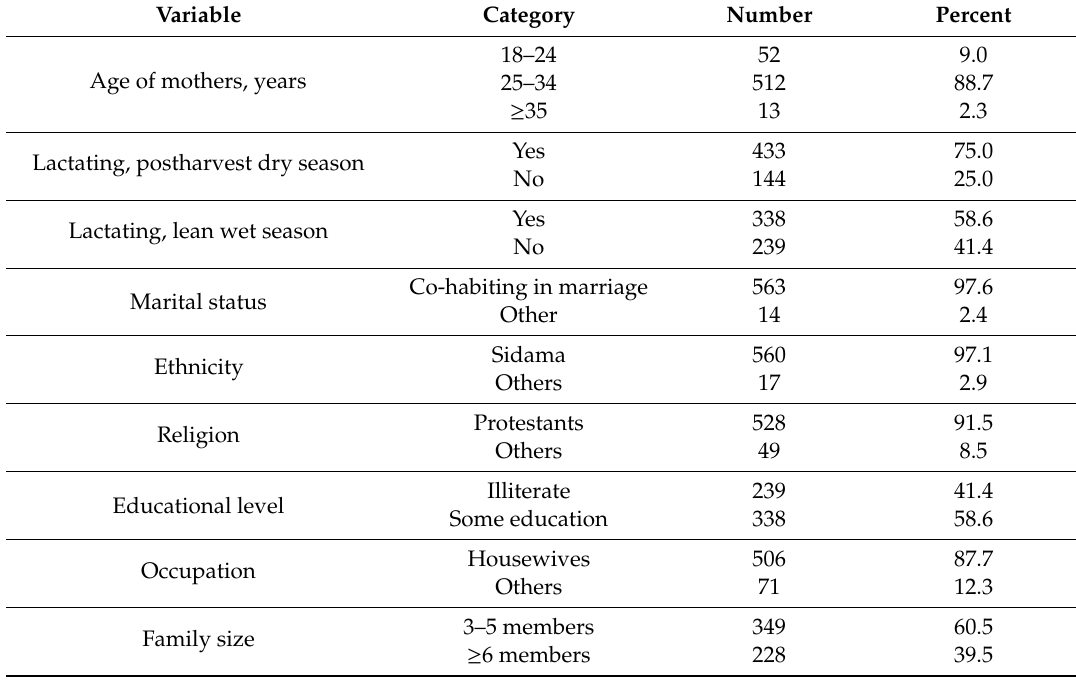
Table 1. Sociodemographic characteristics of participants (N =